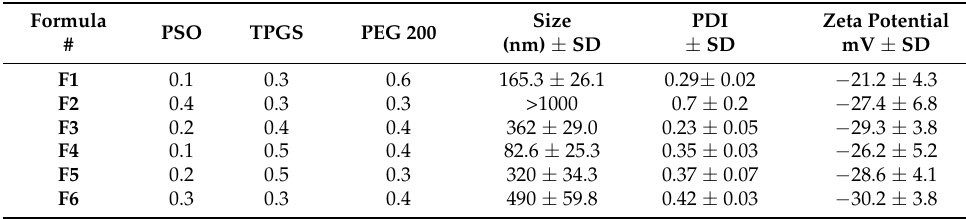
Table 5. SNEDDS formulations and their observed globule